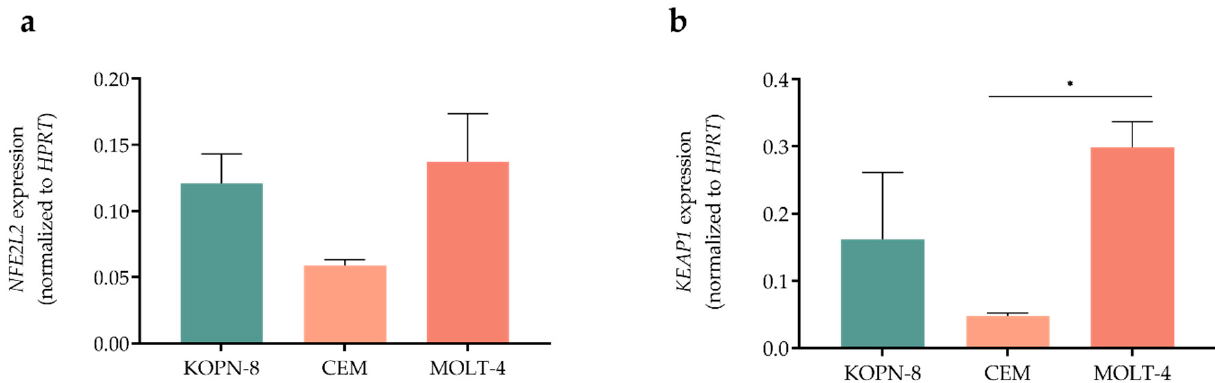
Figure 2. Basal NFE2L2 ( a ) and KEAP1 ( b ) gene expression levels in acute lymphoblastic leukemia cell lines. Results are normalized to HPRT gene (endogenous control) and are expressed as mean ± SEM obtained from 3 independent experiments. * p < 0.05.